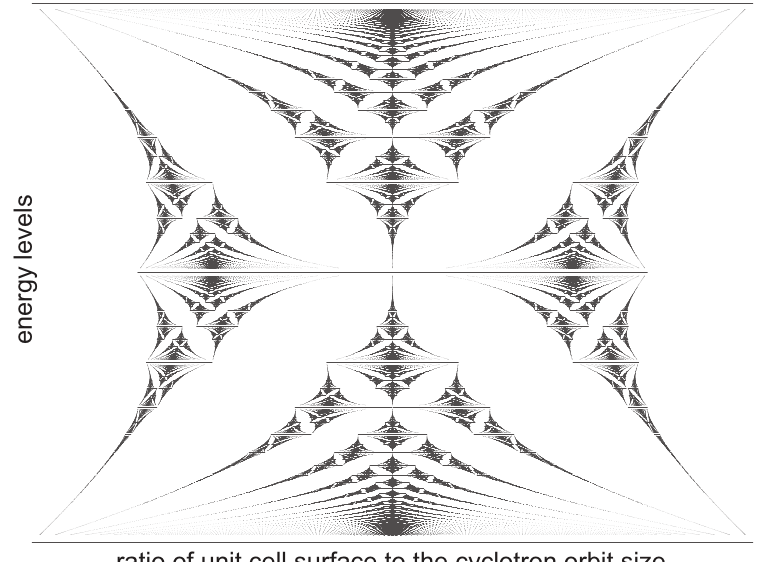
Figure 1. Rendering of Hofstadter butterfly—a fine structure of LLs for the single electron in the periodic square type 2D external potential is shown as the function of the commensurability factor of the cyclotron orbit size with the unit crystal cell. The energy levels are indicated versus the magnetic field flux through the elementary cell, a 2 B , expressed in units of the elementary flux h the ratio of the unit cell surface a 2 to the electron cyclotron orbit size h